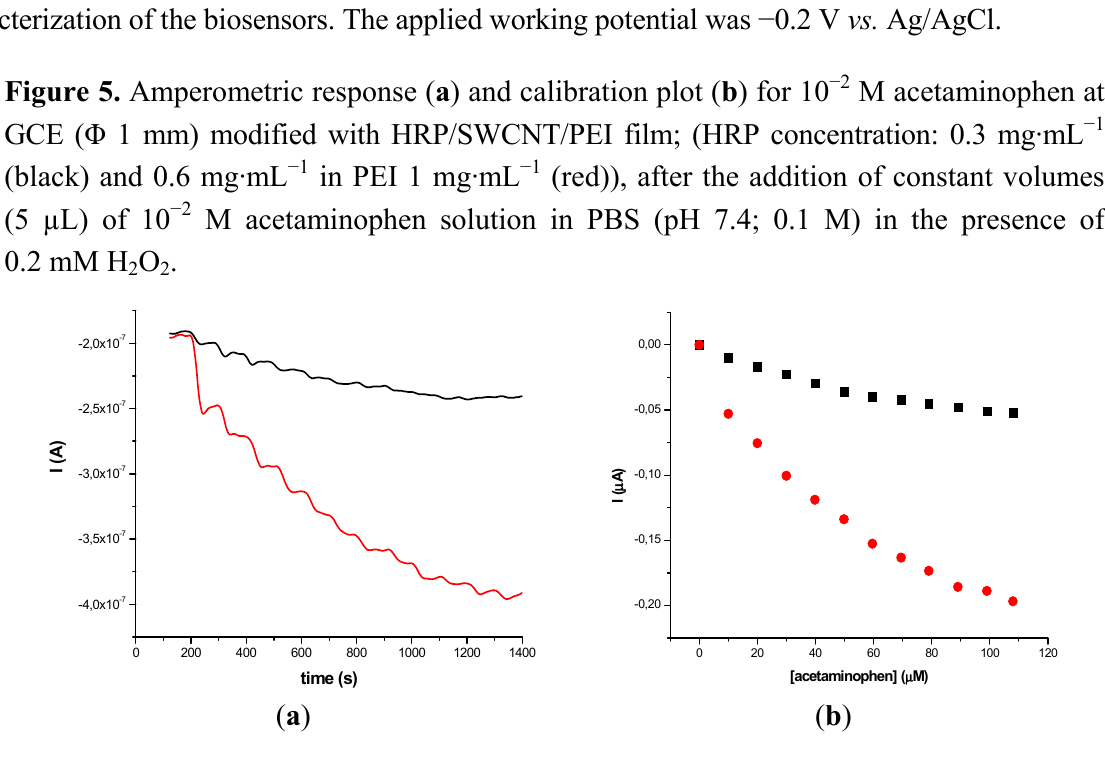
Figure 6. Amperometric response ( a ) and calibration plot ( b ) acetaminophen at GCE ( Φ 4 mm) modified with HRP/SWCNT/PEI film; (HRP concentration: 0.3 mg·mL − 1 (black) and 0.6 mg·mL − 1 in PEI 1 mg·mL − 1 (red)), after the addition of constant volumes (10 µL) of 10 − 2 M acetaminophen solution in PBS (pH 7.4; 0.1 M) in the presence of 0.2 mM H